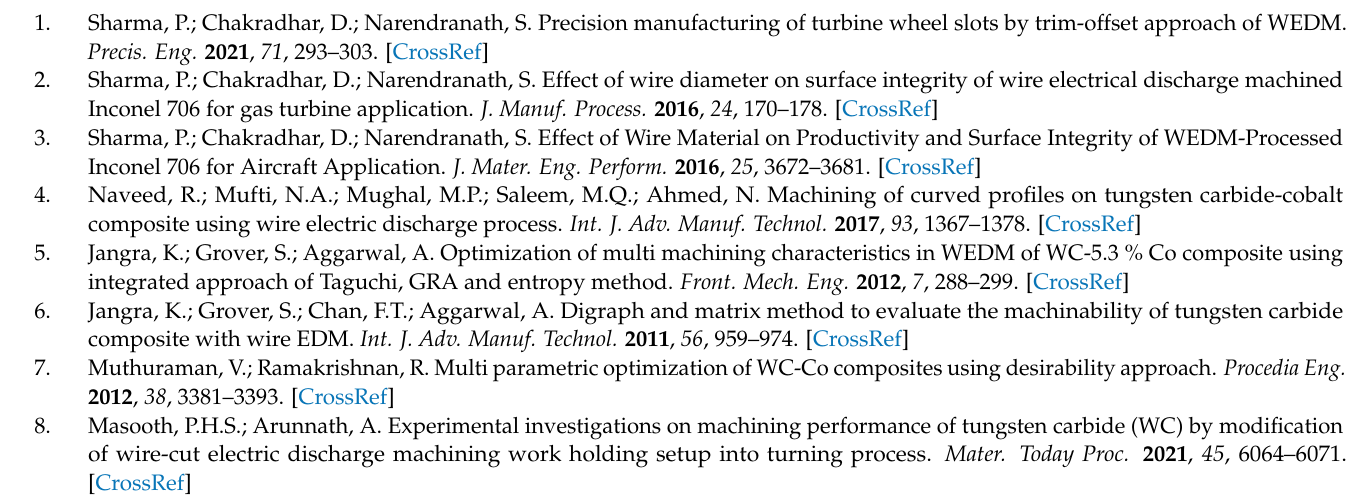
Figure 13. Number of effective discharges in 1 Figure 13 . Number of e ff ective discharges in 1 ms .